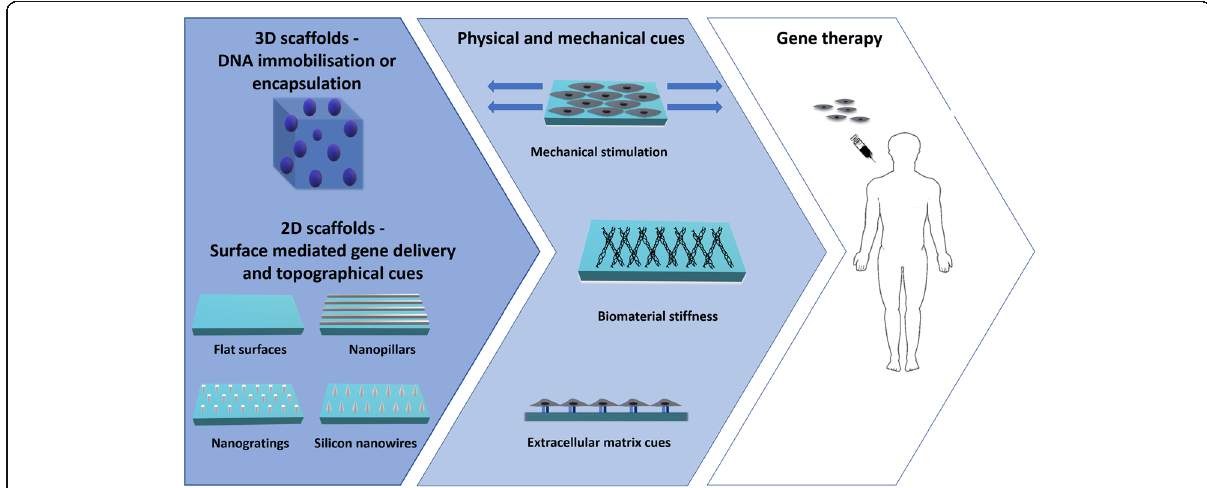
Fig. 2 Schematic representation of biomaterial-mediated gene delivery systems. DNA can be incapsulated/ immobilised into 3D biomaterials or coated on 2D substrates (SMD). 2D materials may be flat, or contain topographical cues, such as nanopillars, nanogratings or silicon nanowires. Physical and mechanical cues (i.e. mechanical stimulation, optimal biomaterial stiffness and ECM cues) may further enhance transfection efficiency. Addition of ECM mimetics may even allow cell type-specific